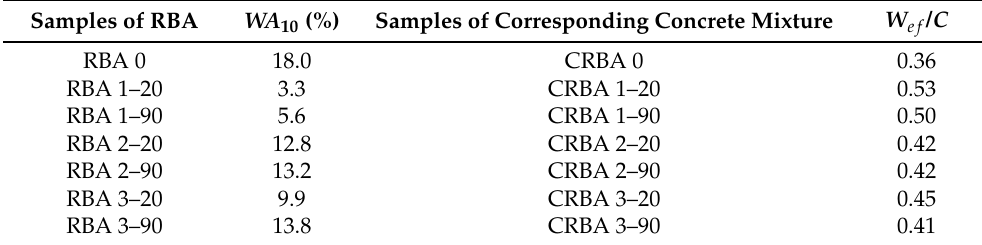
Table 3. Results of short-term water absorption capacity of treated RBA ( WA 10 ) and corresponding effective w/c ratio ( W ef / C ) of concrete mixtures Concrete based on treated recycled brick aggregate